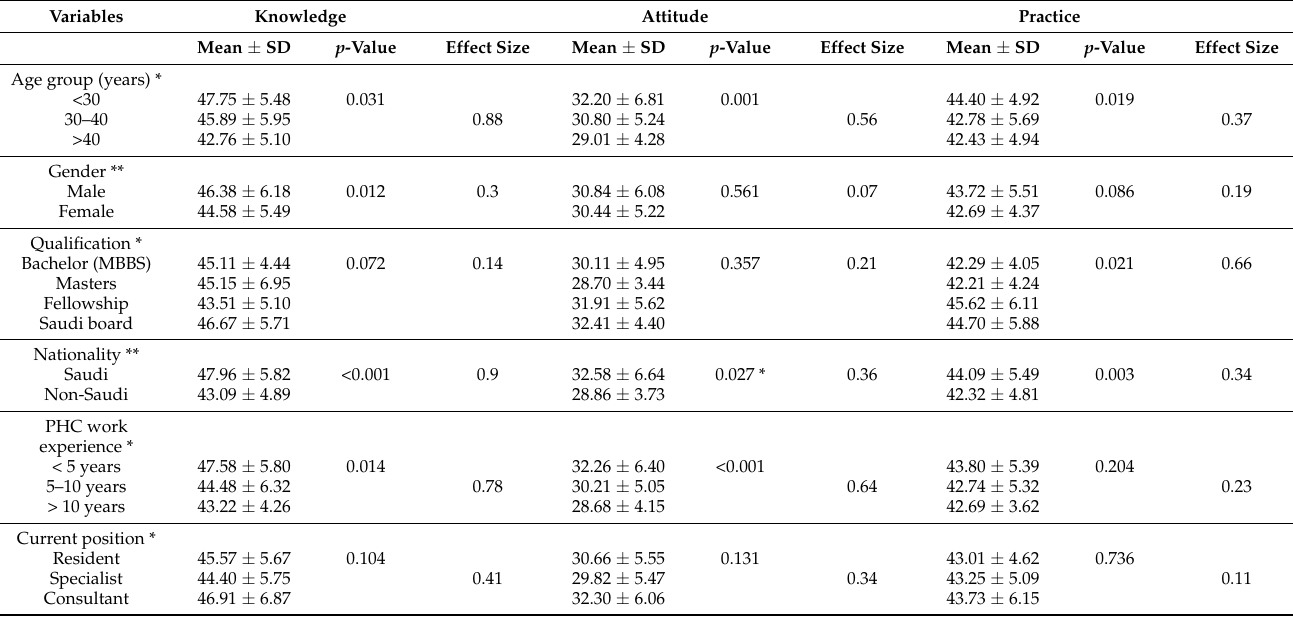
Table 3. Relationship between the knowledge, attitude, and practice scores of diabetic retinopathy (DR) and the socio- demographic characteristics of the study